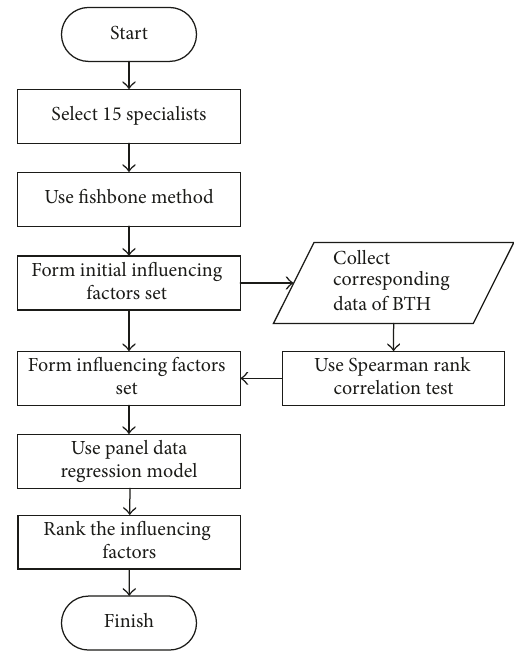
Figure 3: The process of the PM2.5 influential factors analysis.